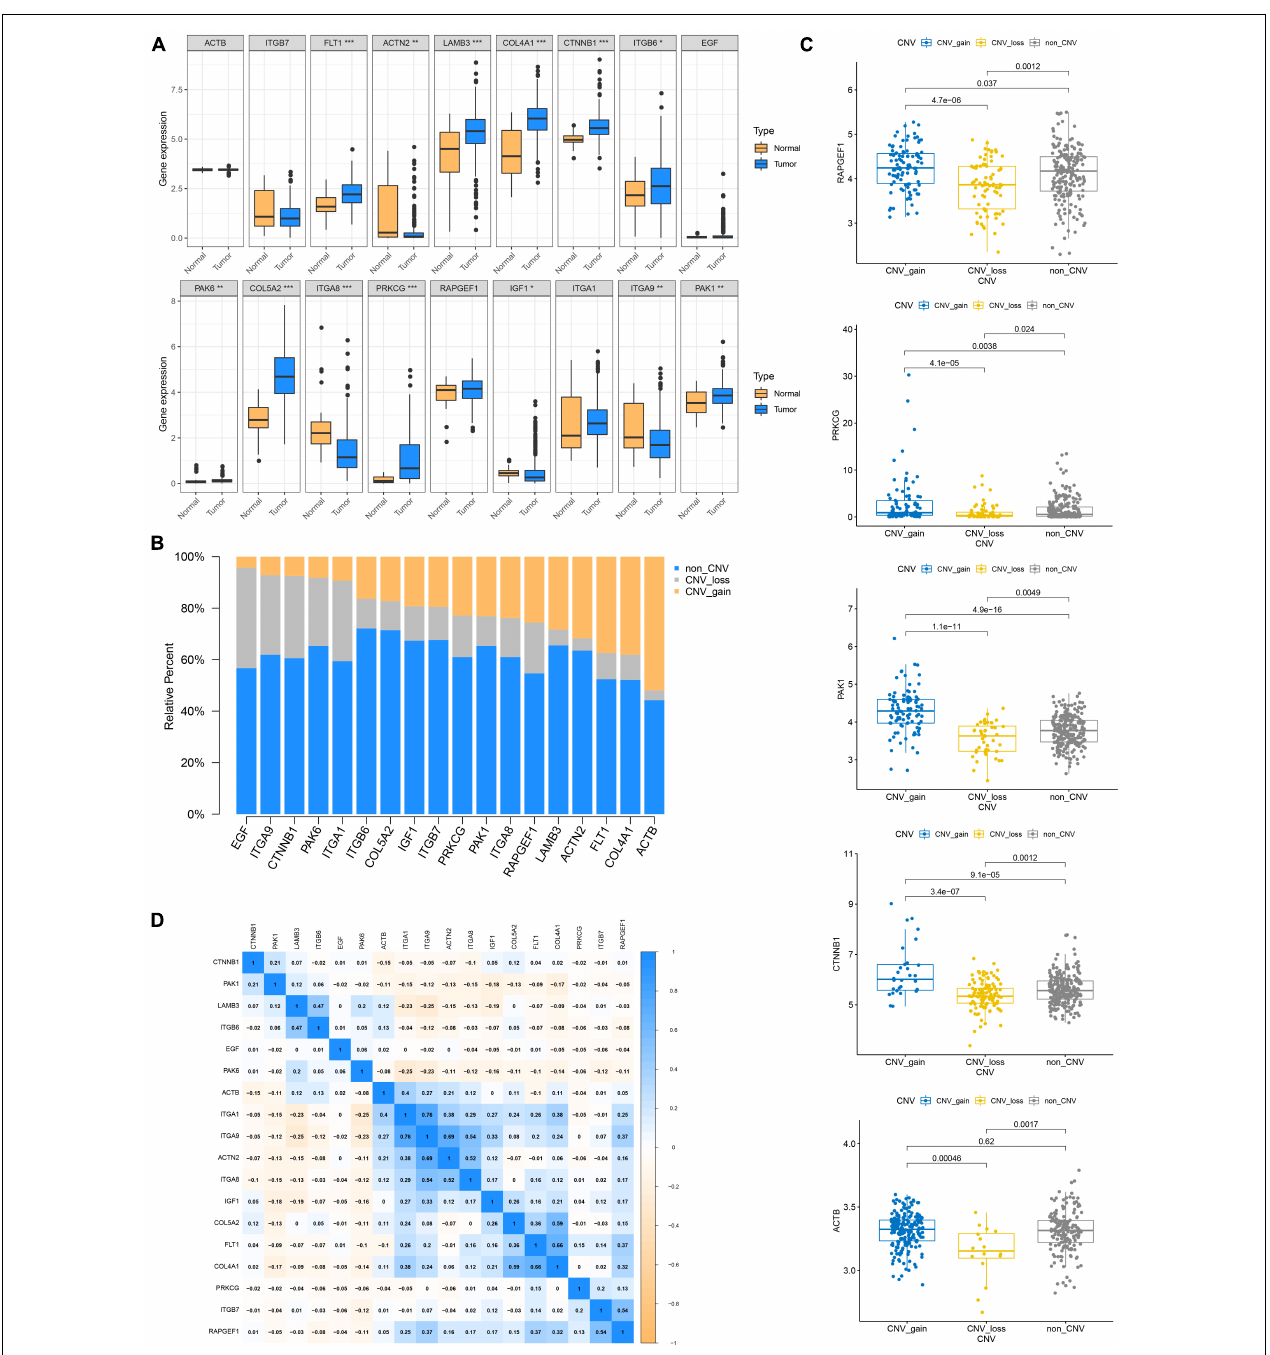
FIGURE 4 | Genetic and transcriptional alteration of focal adhesion-related genes. (A) The expression of genes related to focal adhesion is different between normal and tumor tissues, * P < 0.05; ** P < 0.01; *** P < 0.001. (B) CNV again, CNV loss, and non-CNV frequency of focal adhesion-related genes in the TCGA cohort. (C) Correlation between CNV alteration of focal adhesion-related genes and gene expression. (D) Correlation between expression levels of focal adhesion-related genes.